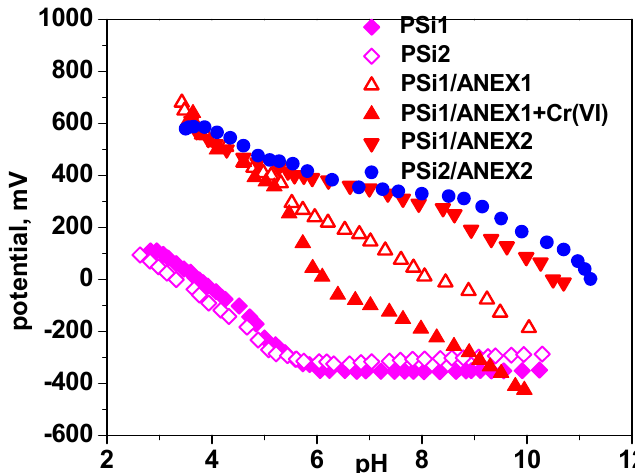
Figure 4. Potentiometric titrations of bare silica microspheres (PSi1 and PSi2) and of the PSi / ANEX composites. pH PZC for PSi1 / ANEX1 has been measured both before (empty triangle) and after loading with Cr(VI) (filled triangle).